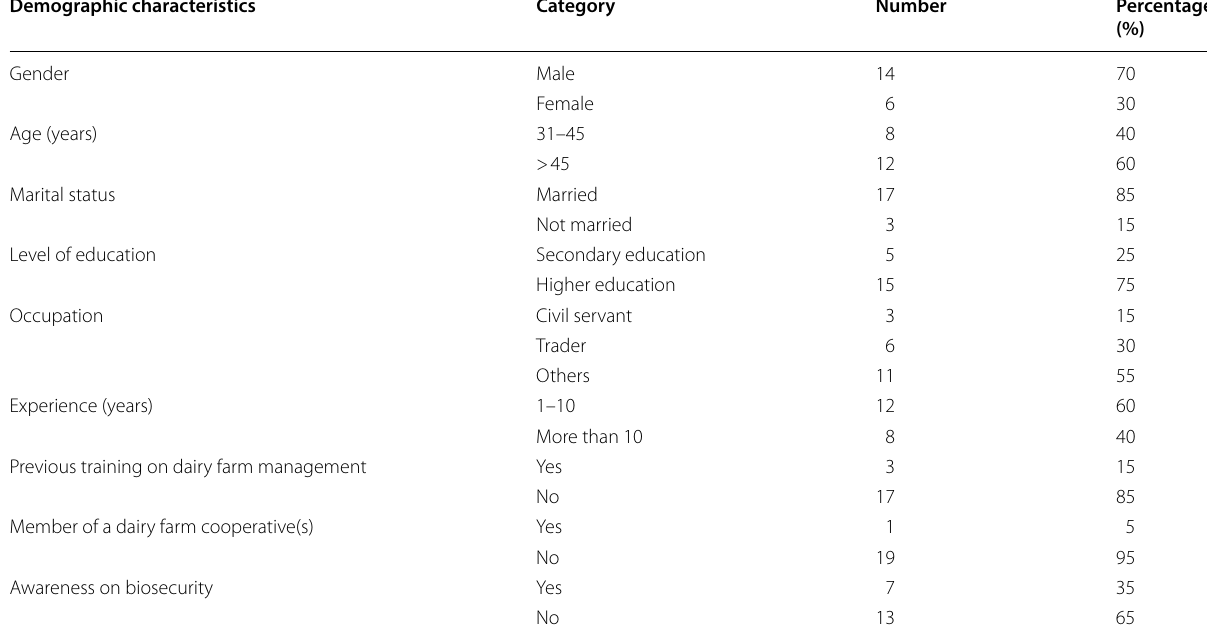
Table 3 The demographic characteristics dairy farm owners Demographic